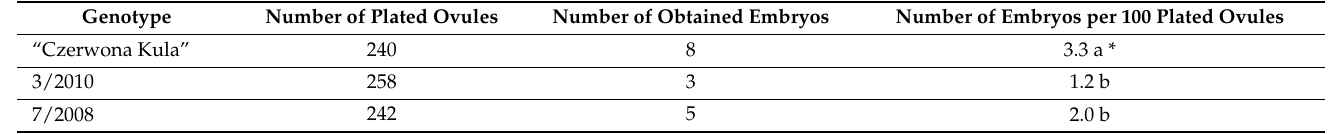
Table 3. Influence of the genotype on the effectiveness of gynogenesis in red beet on B5-6 medium